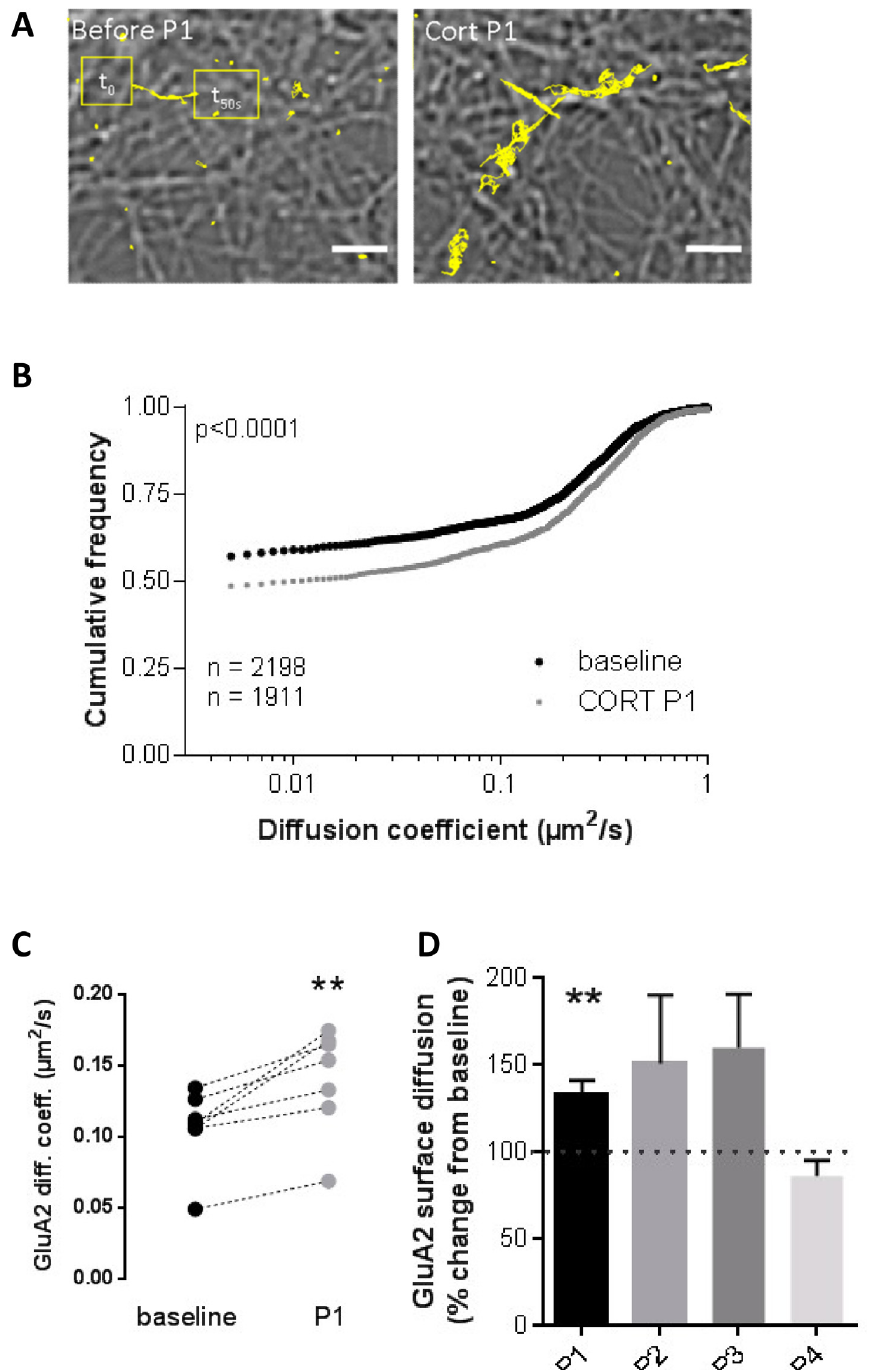
Fig 2. Consecutive corticosterone pulses differentially influence GluA2-AMPAR trafficking. (A) Representative trajectory (10 – 50 s duration) of surface GluA2 before and after the first pulse of corticosterone (peak at 100 nM). Scale bars represent 5 μ m. (B) The total diffusion coefficient was significantly increased after the first pulse of corticosterone (cumulative frequency, n = 2198 for control and n = 1911 for corticosterone). (C) The first corticosterone pulse (peak at 100 nM) significantly increased the mean surface diffusion of the GluA2 receptor (mean, n = 7). (D) The corticosterone-induced increase in GluA2 surface diffusion was only observed after the first pulse (bars represent mean ± SEM, n = 1441 –